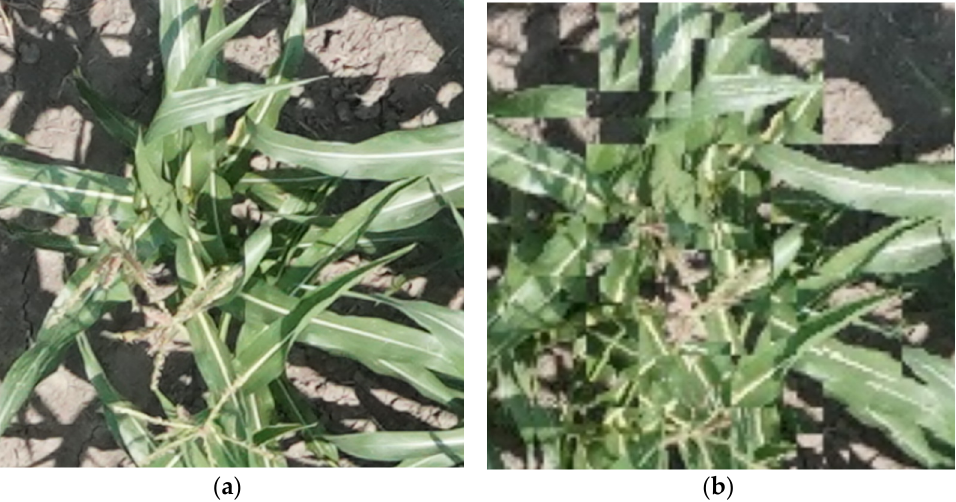
Figure 3. Example of ( a ) a red–green–blue (RGB) image covering an agricultural field and ( b ) corresponding orthophoto.